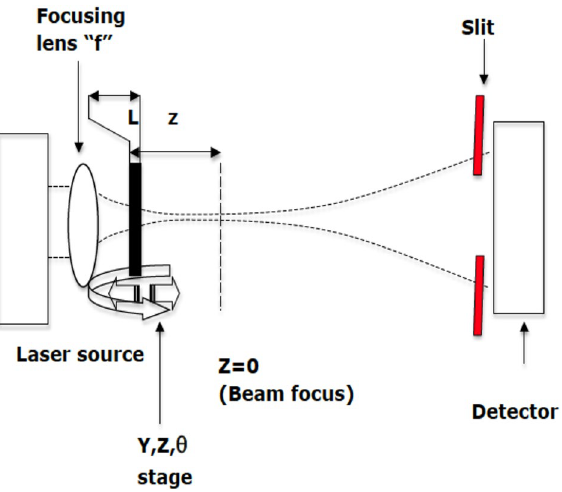
Figure 2. Schematic configuration of the Z–scan experimental setup used in the present study. The experimental setup consists of a CW laser source operating at 650 nm wavelength with a total power of 5